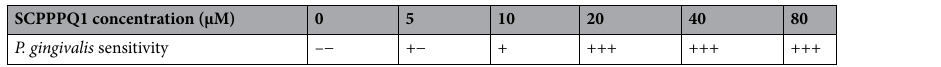
Table 1. MIC values of SCPPPQ1 against P. gingivalis. –− corresponds to a SCPPPQ1 concentration resulting in no effects on P. gingivalis growth while + + + is a concentration showing no growth of the microorganism.